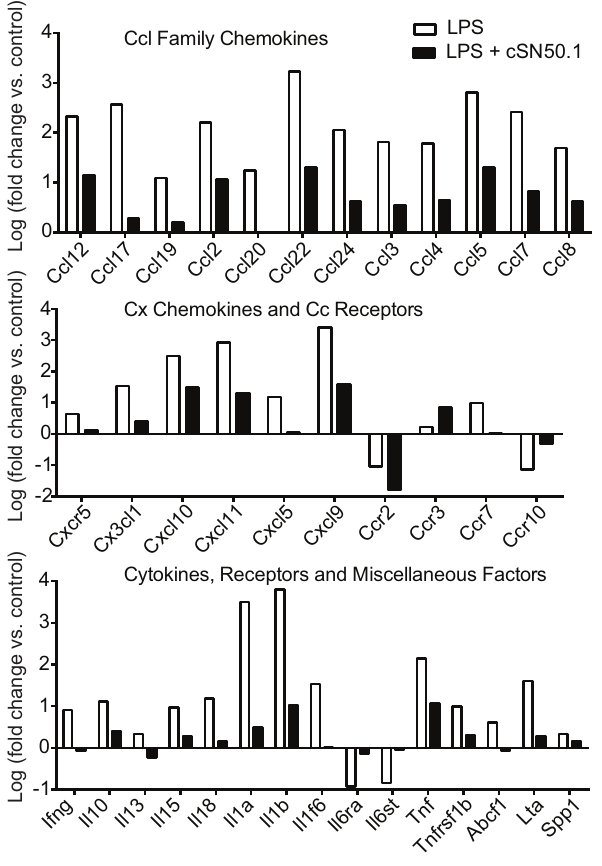
Figure 1. qRT-PCR-based gene expression analysis of LPS- challenged BMDMs in the absence or presence of NTM. Ccl family chemokines, Cx chemokines and Cc receptors, and cytokines, receptors and miscellaneous factors from an 84 gene array exhibiting a . 0.5 log fold change in LPS-stimulated primary macrophages compared to unstimulated control cells.